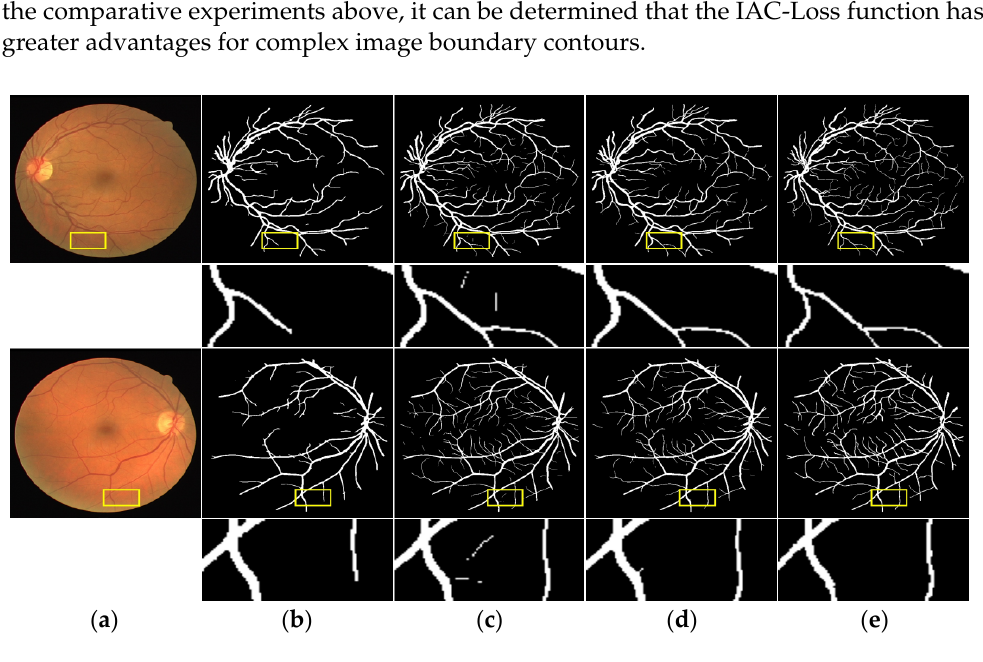
Figure 8. Comparison of +IAC-Loss with related loss function results. Lines 2 and 4 are the local details respectively. ( a ) Test Image; ( b ) +AC-Loss; ( c ) +CE-Loss; ( d ) +IAC-Loss; ( e ) Ground truth.